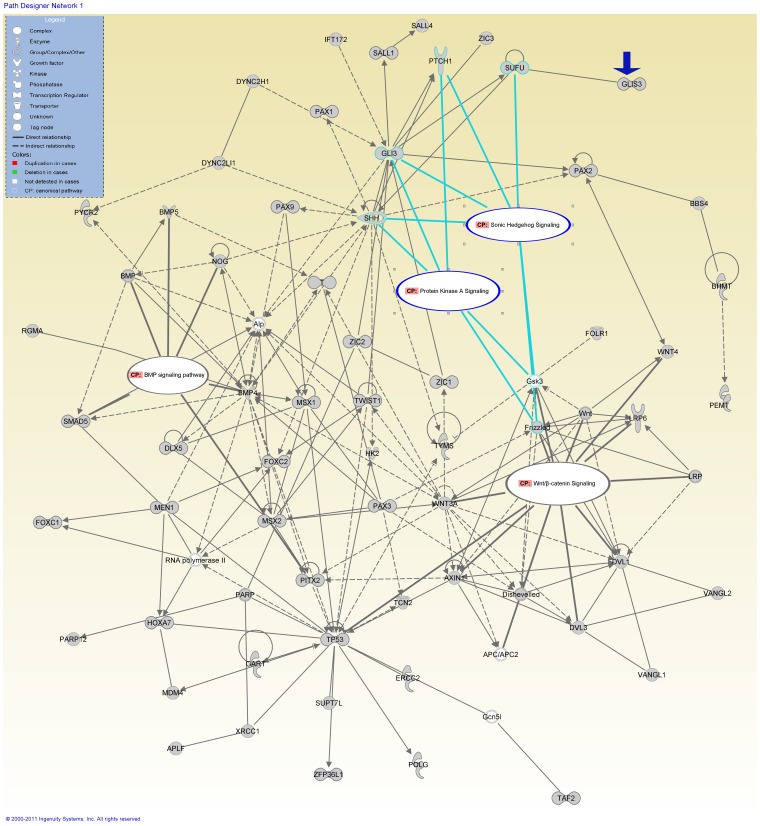
Top bio-functional networks in the integrated list of 361 genes.“Organ Development, Tissue Development, Embryonic Development” was identified as top network in the integrated list of 361 genes. The interactions exist between the novel pathway and the known pathway of NTDs.